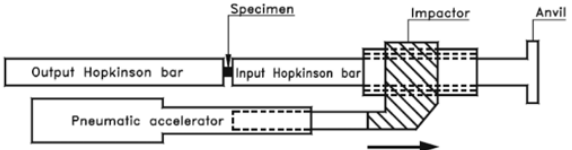
Fig. 5. Schematic view of the split Hopkinson tensile bar setup.